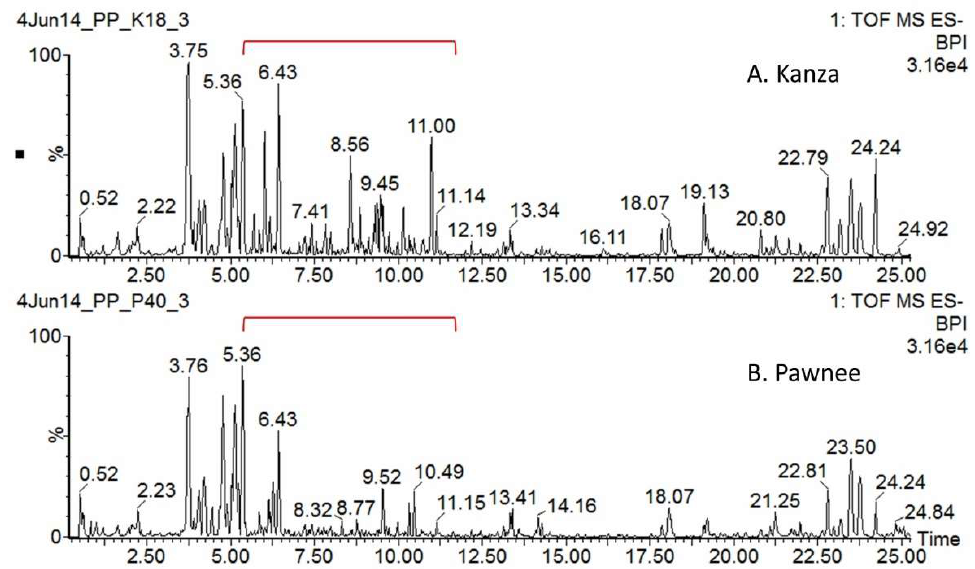
Figure 1. UHPLC-QTOF-MS base peak chromatograms of Kanza ( A ) and Pawnee ( B ) leaves. Dramatic differences were found between the Kanza and Pawnee metabolic profiles, particularly from 5 to 12 min outlined in red brackets. Numerous metabolites elute in this region, including phenolics and flavonoids.